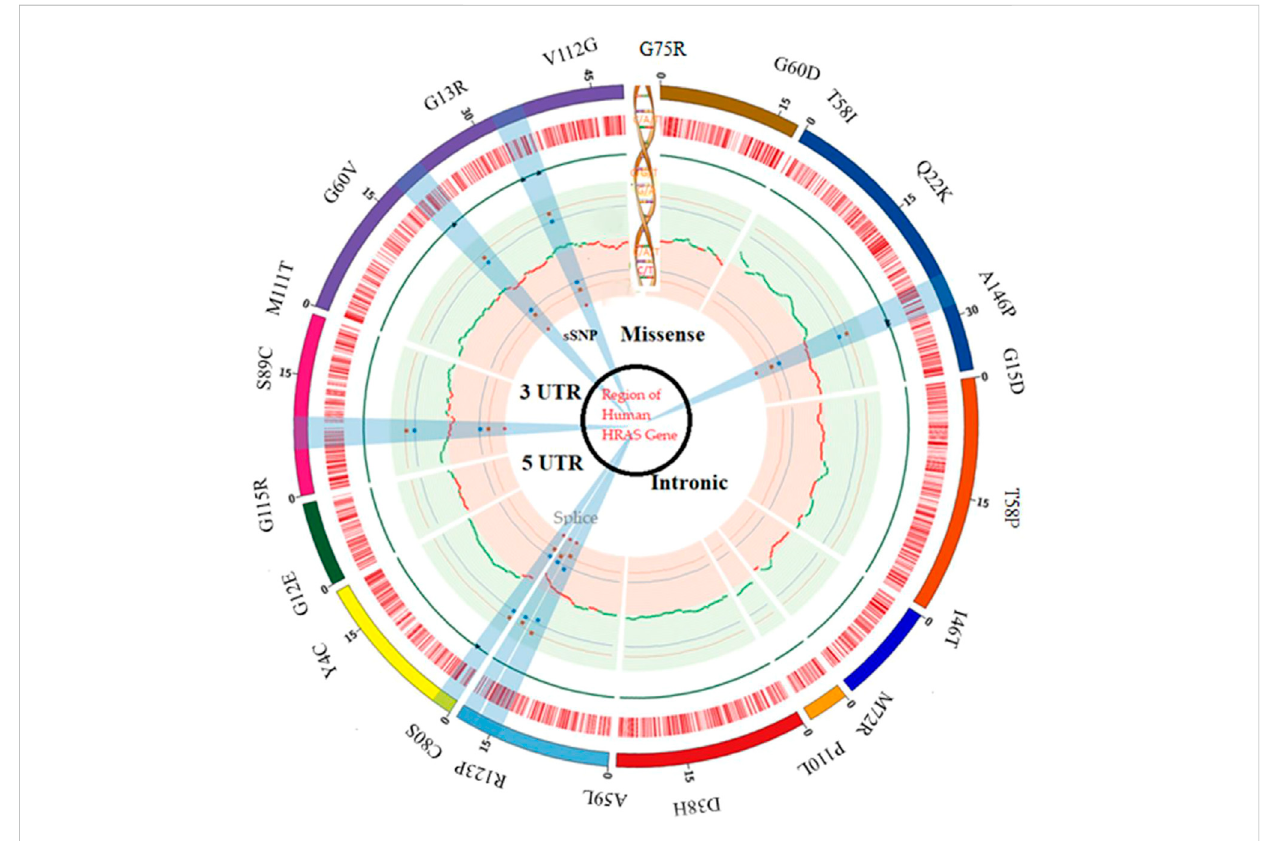
FIGURE 1 SNP distribution in a different region of the human HRAS